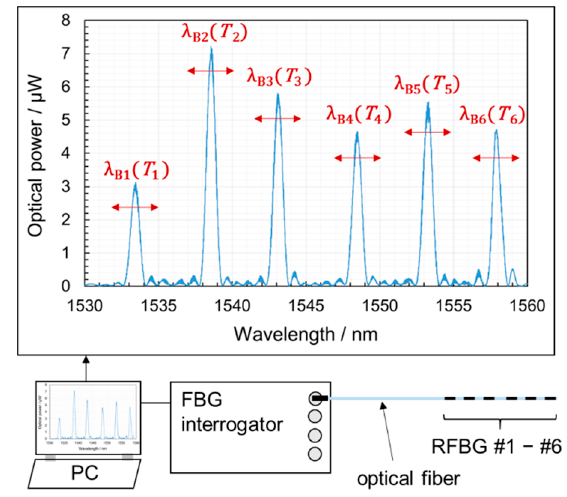
Figure 2. Principle of fiber Bragg grating (FBG) multiplexing.